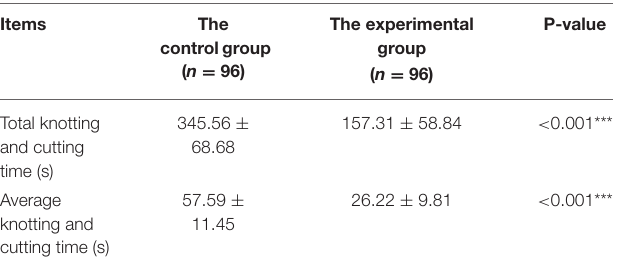
TABLE 1 | Calculation of the total and average knotting and cutting time during heart valve surgery. Items